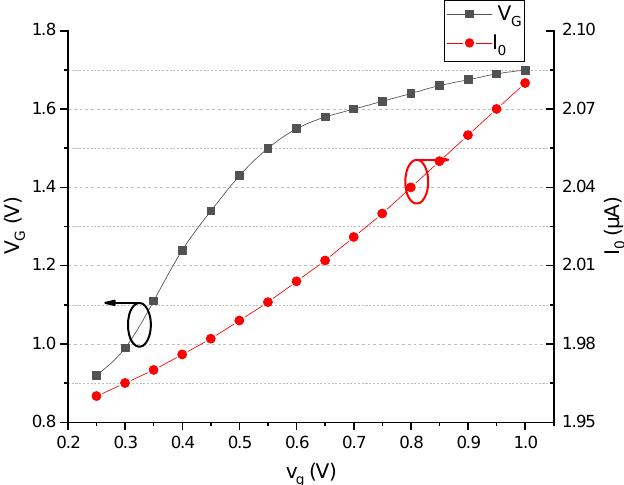
Figure 15. The simulation results of I 0 and V G with v g varying.